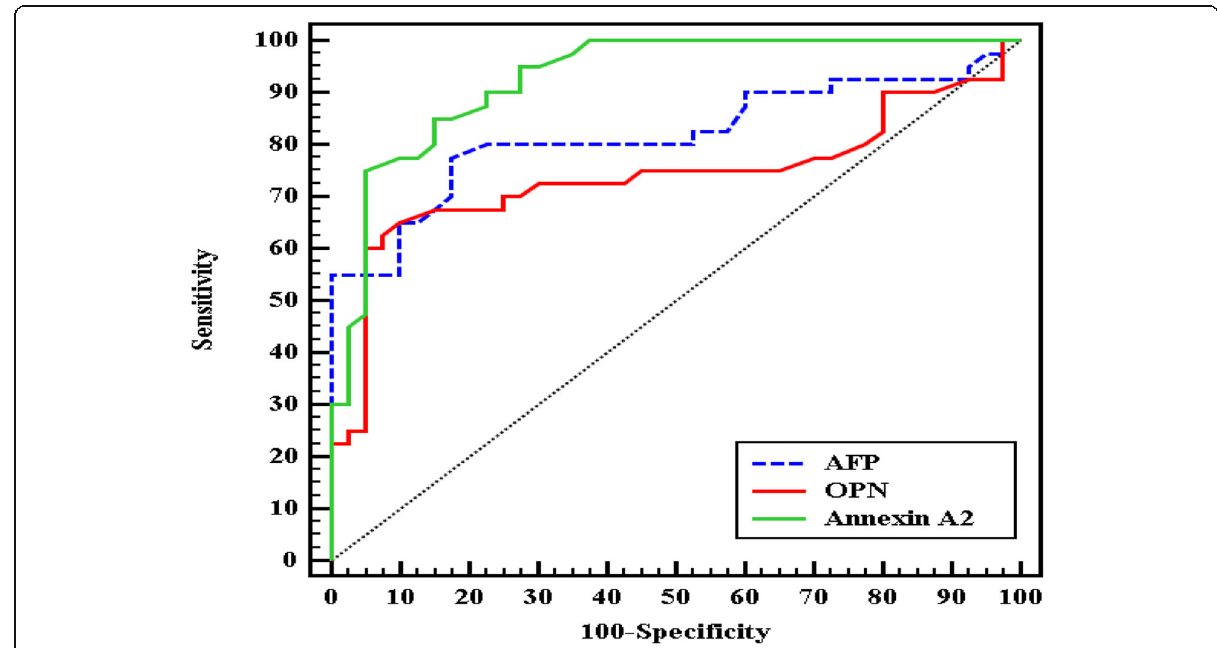
Fig. 2 ROC curve for AFP, OPN, and ANXA2 to diagnose